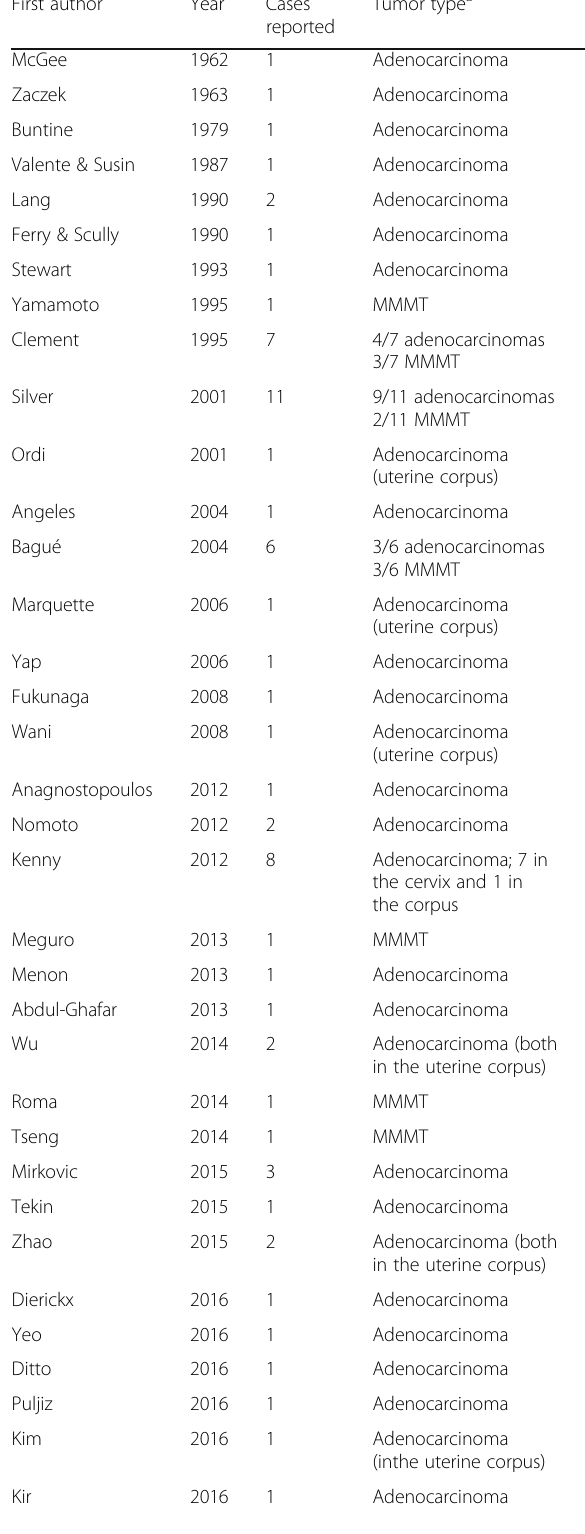
Table 1 Summary of cases of mesonephric carcinoma of the cervix and the uterine corpus reported in the literature, including the present case